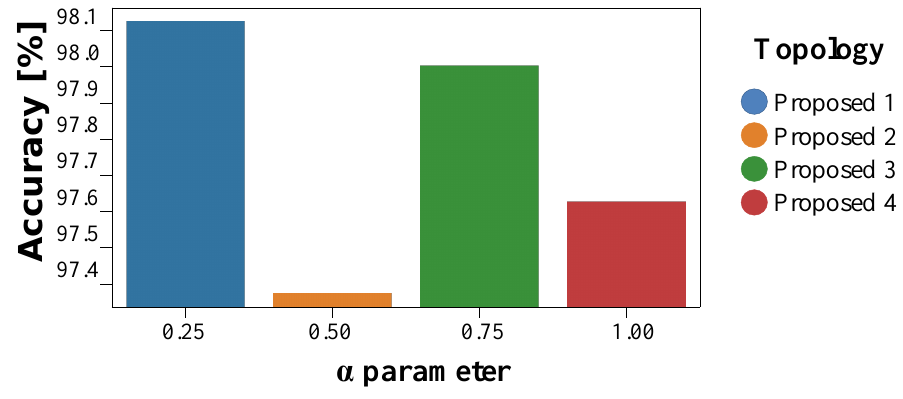
Figure 19. Test accuracy for different values of alpha parameters for the